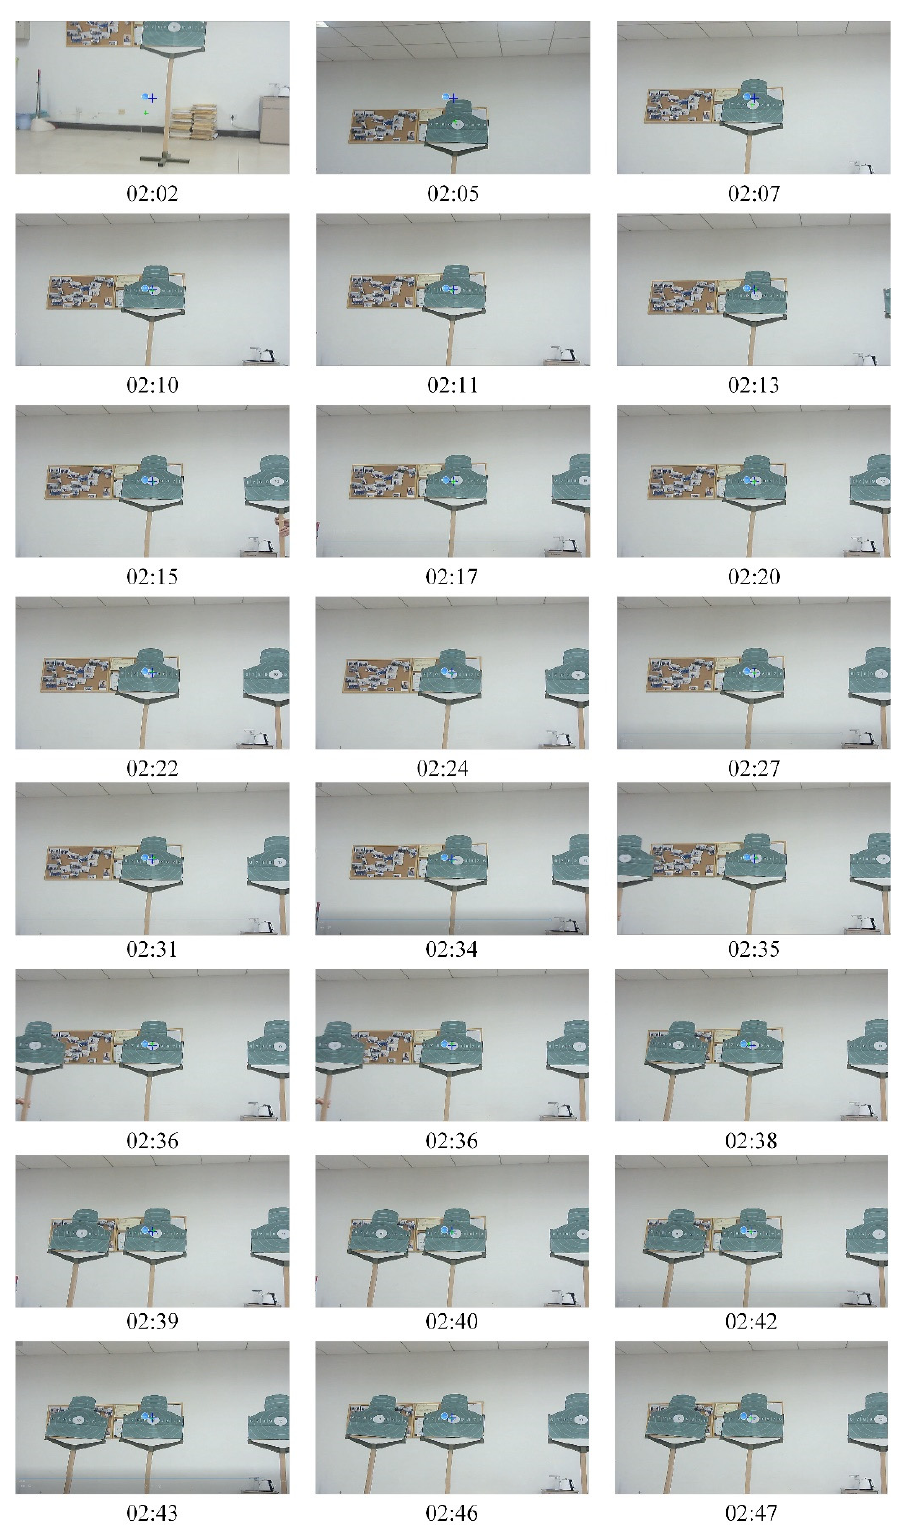
Figure 20 present the gaze process 24 different time visual aiming state.